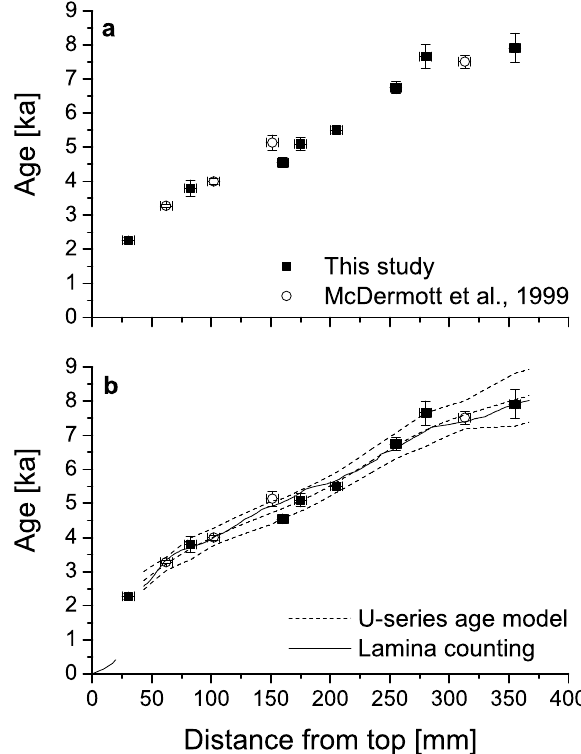
Fig. 2. (a) U-series ages determined for ER 76 in this (filled squares) and a previous study (open circles, McDermott et al., 1999) plotted against the distance from top of the stalagmite. The McDermott et al. (1999) ages were recalculated using the most recent half-lives (Cheng et al., 2000) and corrected for detrital contamination as described in the text. Error bars include 2 σ -age uncertainties and thickness of the individual samples. (b) Age models for stalagmite ER 76. The age model based on the U-series ages was calculated using the algorithm of Heegaard et al. (2005, dashed line). The en- veloping lines represent the corresponding 95%-confidence limits. The bold, solid line shows the age model based on counting of an- nual lamina from the bottom of the stalagmite. Further details are given in the